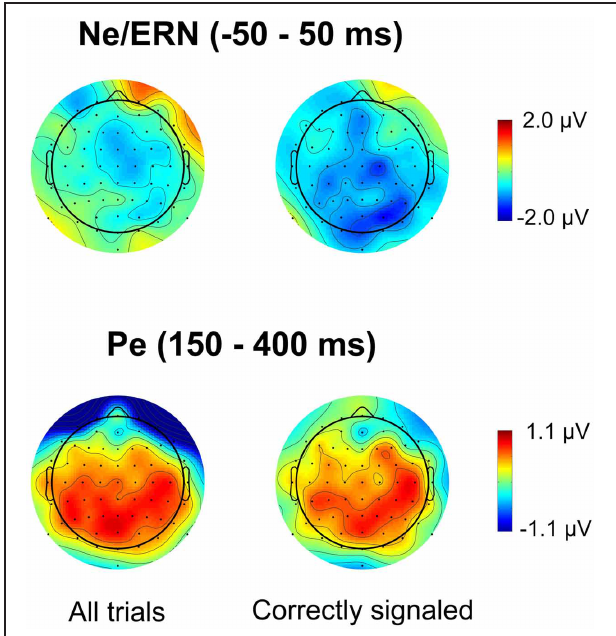
FIGURE 5 | Spatial distribution of ERPs in RT matched data for the difference between errors in the lowSP condition and errors in the highSP condition. Upper row: Time period of the Ne/ERN ( − 50 – 50ms). Lower row: Time period of the Pe (150–400 ms). Left column: Data from all errors. Right column: Data from signaled errors. HighSP = high speed pressure. LowSP = low speed pressure.